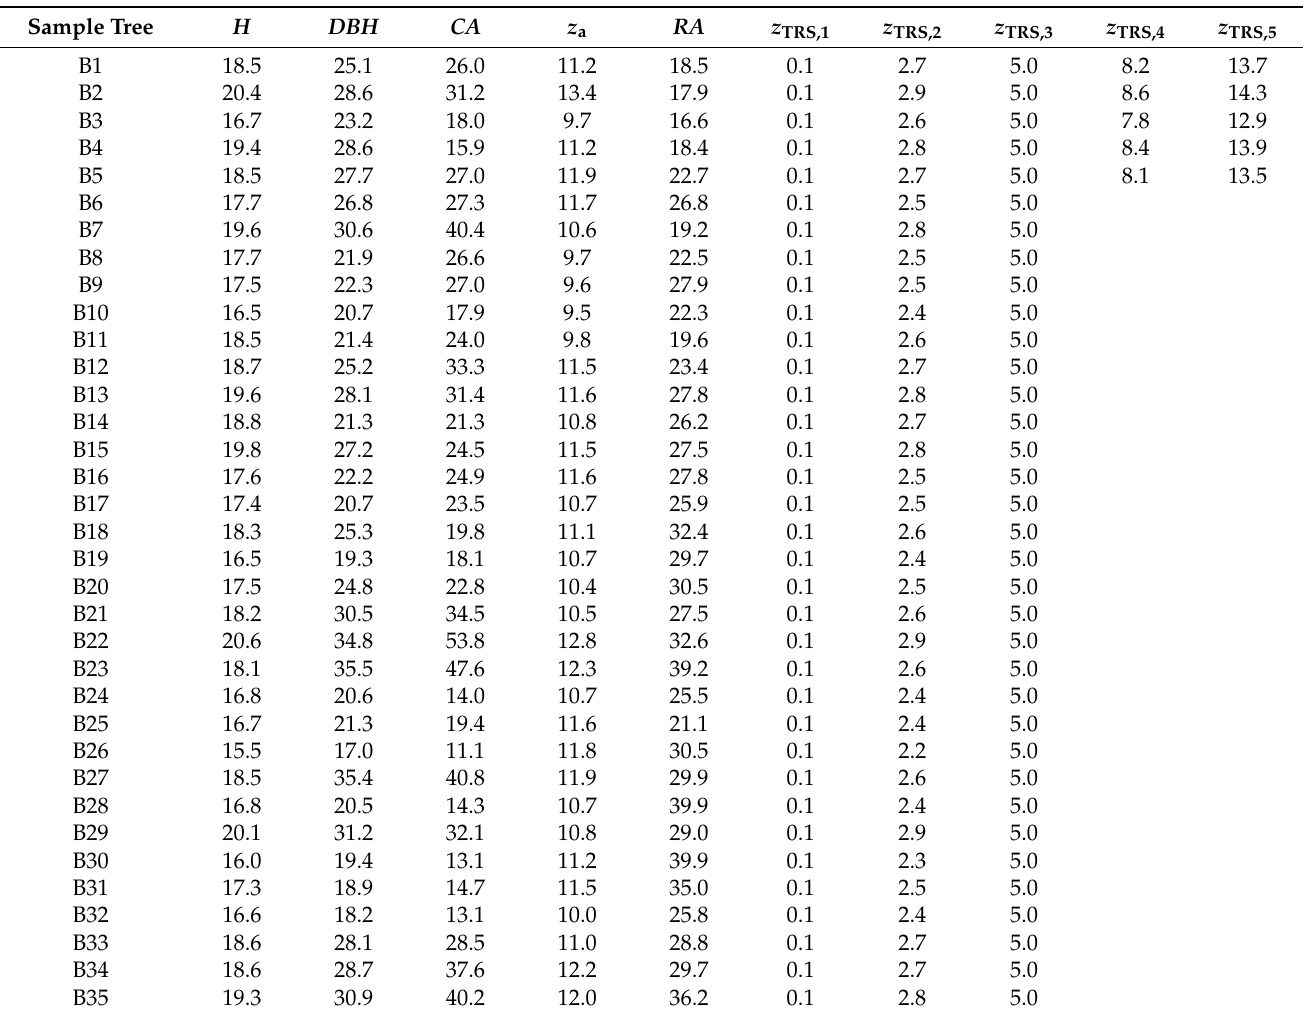
Table 1. Height ( H , m), stem diameter at breast height ( DBH , 1.3 m a.g.l., cm), and crown area ( CA , m 2 ) of the sample trees B1 to B35. z a is the height of pulling rope anchor point (m), RA is the pulling rope angle ( ◦ ), and z TRS,1 to z TRS,5 are the Tree Response Sensor (TRS) stem tilt measurement